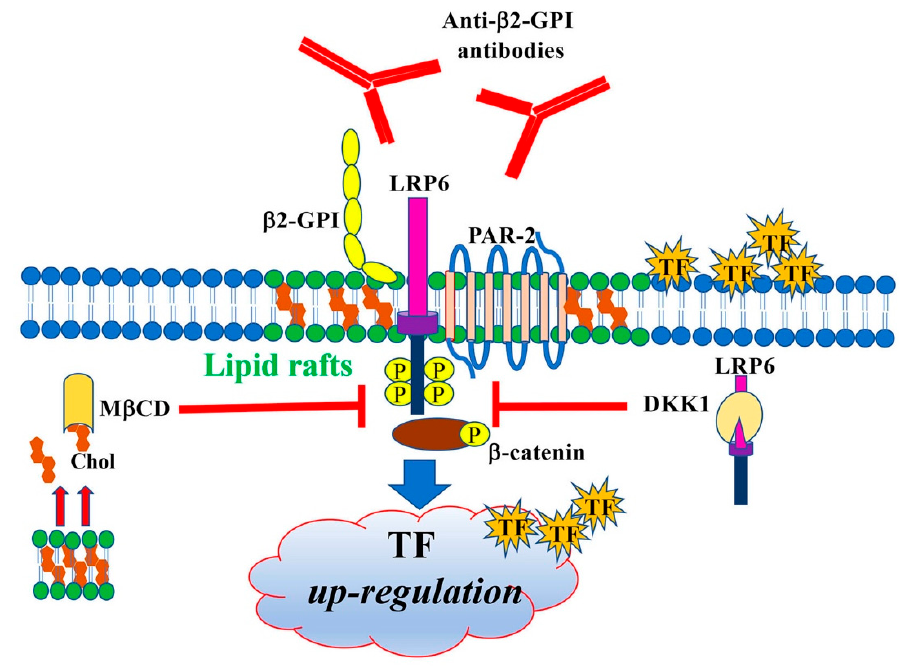
Figure 5. Signal transduction pathway triggered by anti- β 2-GPI antibodies. Schematic drawing depicting the signal transduction pathway triggered by anti- β 2-GPI antibodies, involving LRP6 and β -catenin phosphorylation, through lipid rafts. It leads to a procoagulant EC phenotype characterized by the expression of TF.